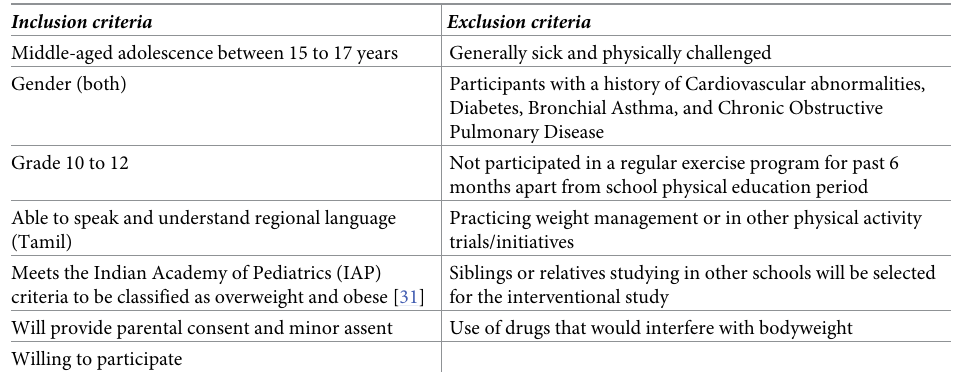
Table 1. SISMA-PA: Selection